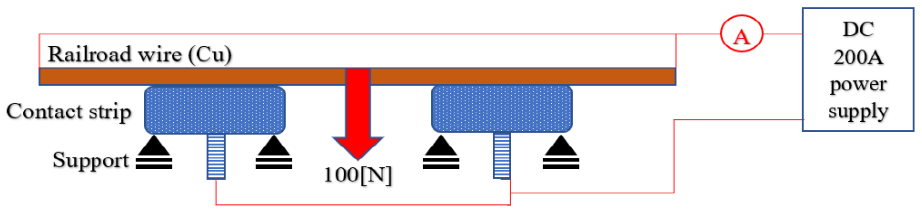
Figure 2. Diagram of the measuring system. Table 1. Copper percentage in the carbon–copper composite strips [21].